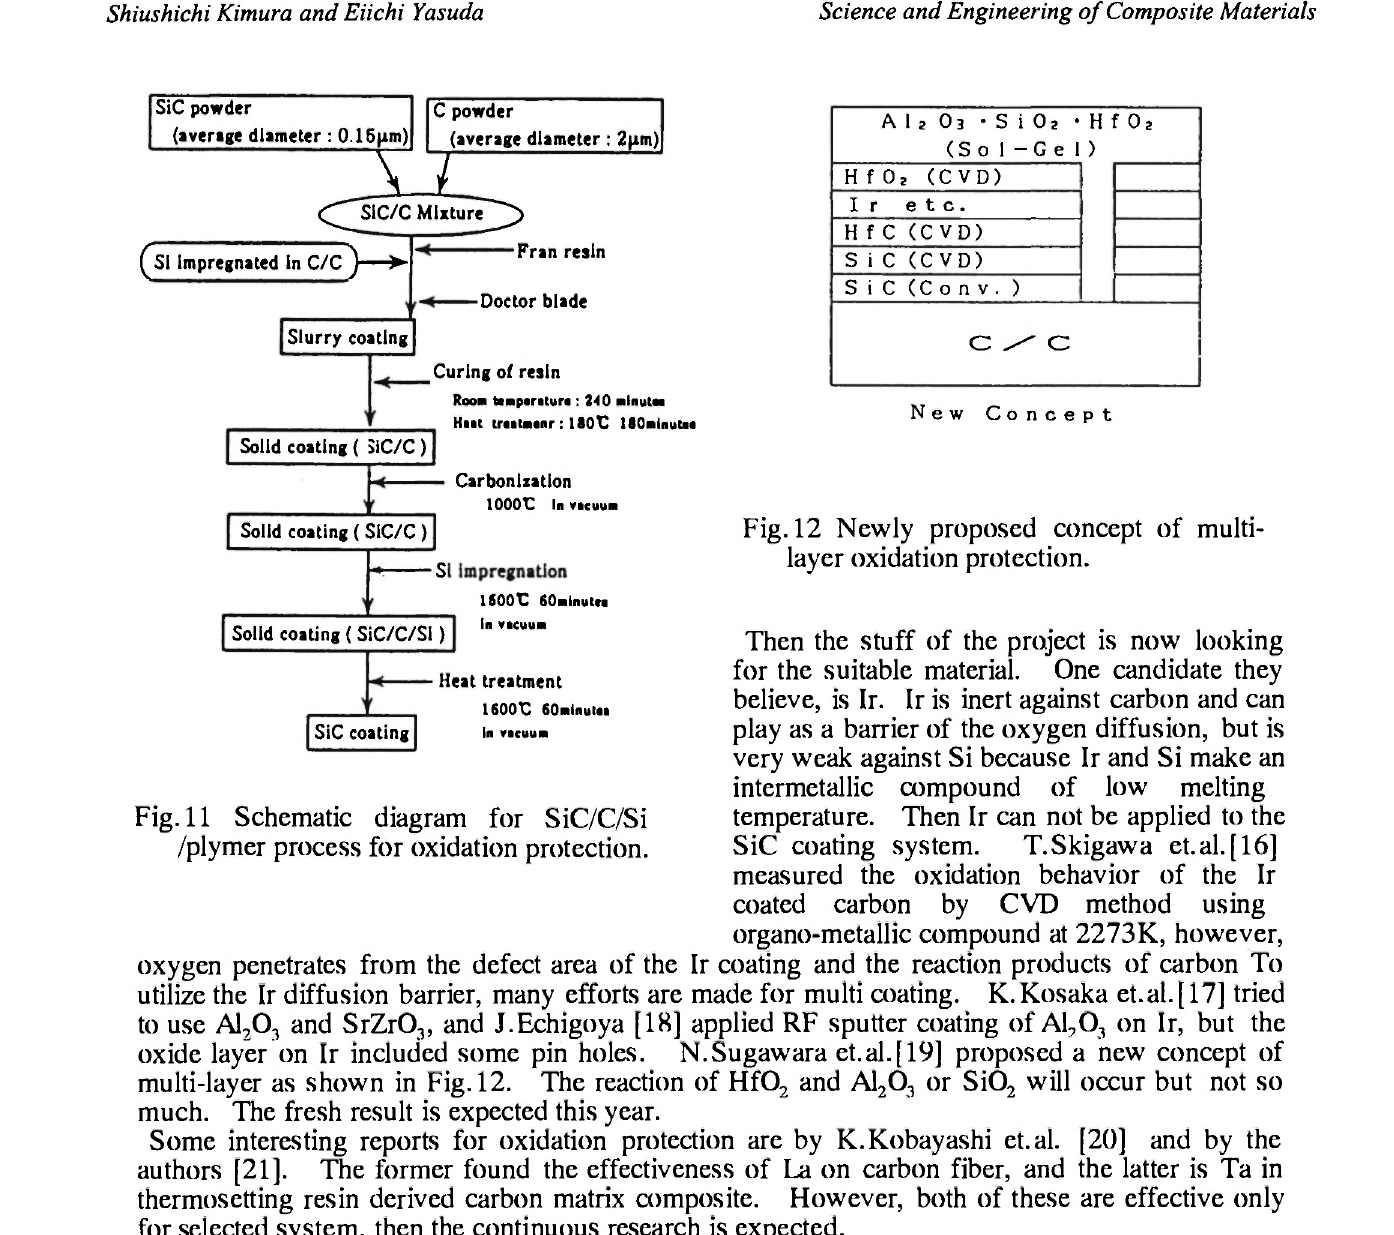
Fig. 12 Newly proposed concept of multi- layer oxidation protection.